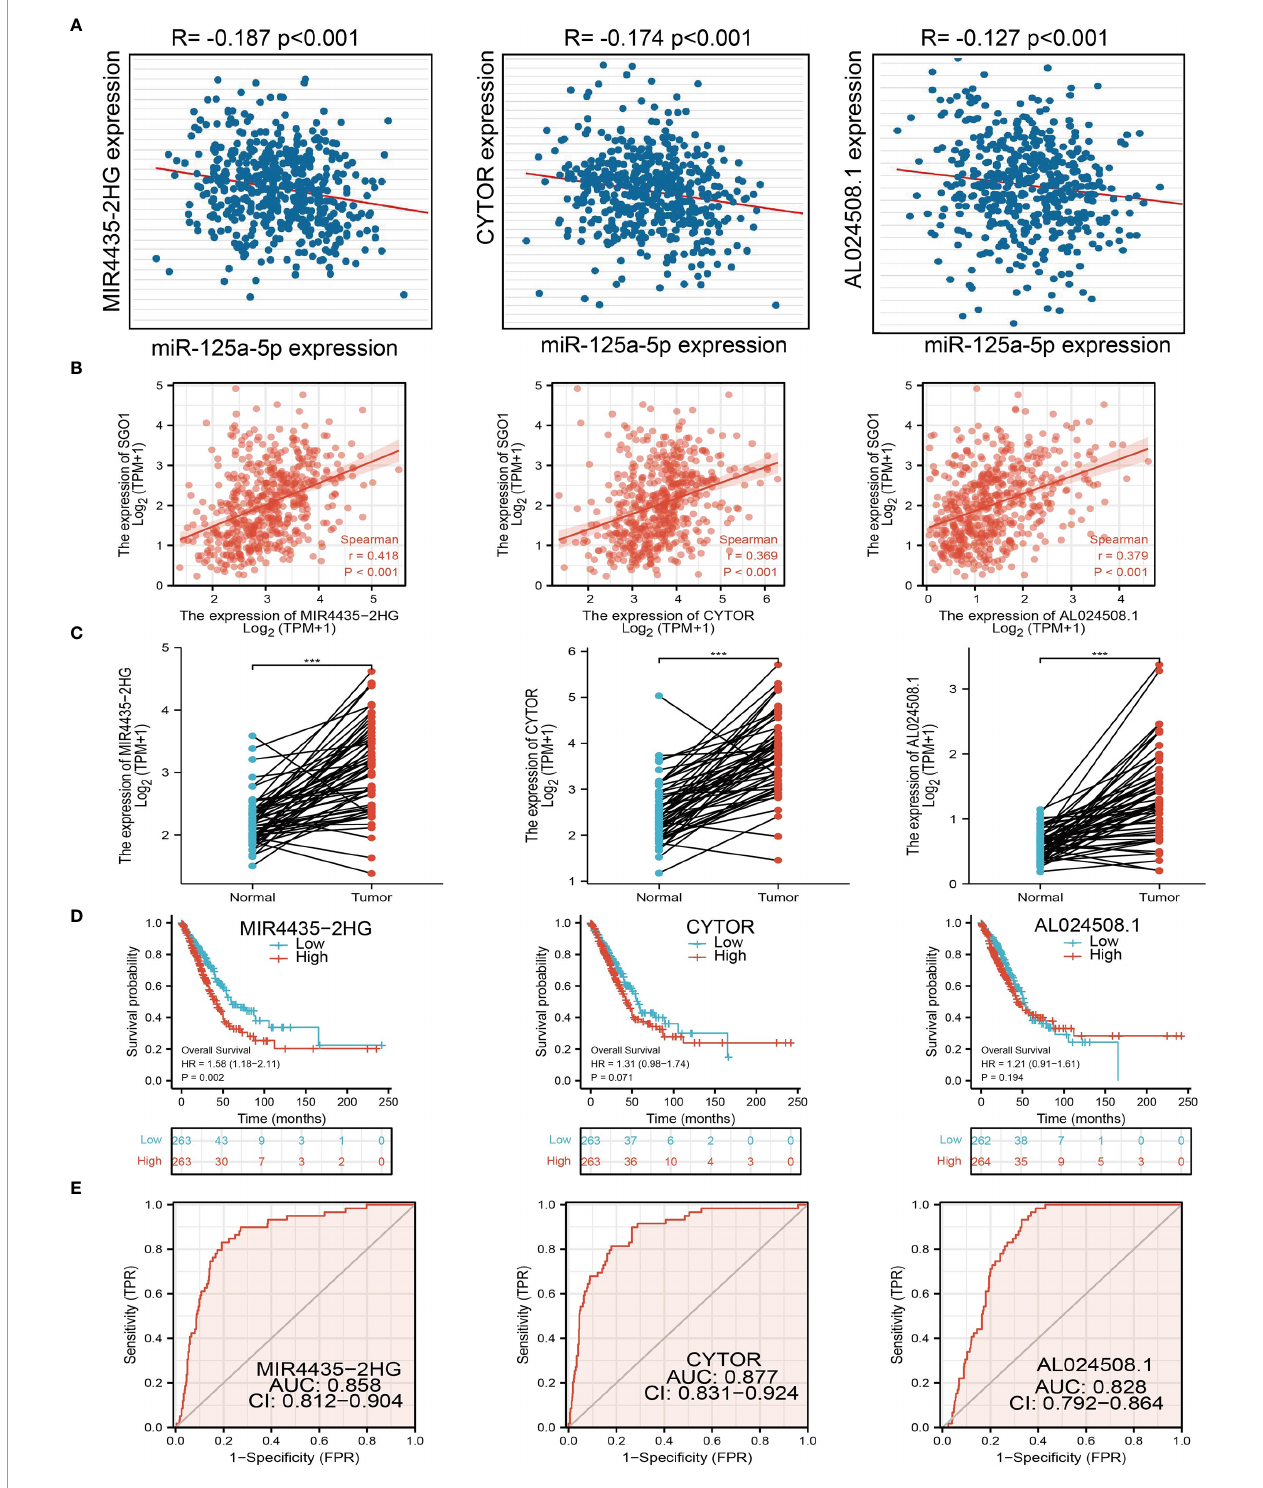
FIGURE 10 | Analysis of the potential lncRNAs of miR-101-3p. (A) Correlations between miRNA-125a-5p expression and lncRNAs (MIR4435-2HG, CYTOR, and AL024508.1) in LUAD. (B) Correlations between SGO1 expression and lncRNAs (MIR4435-2HG, CYTOR, and AL024508.1) in LUAD. (C – E) The expression levels and prognostic and diagnostic values of lncRNAs (MIR4435-2HG, CYTOR, and AL024508.1) in LUAD ***P <